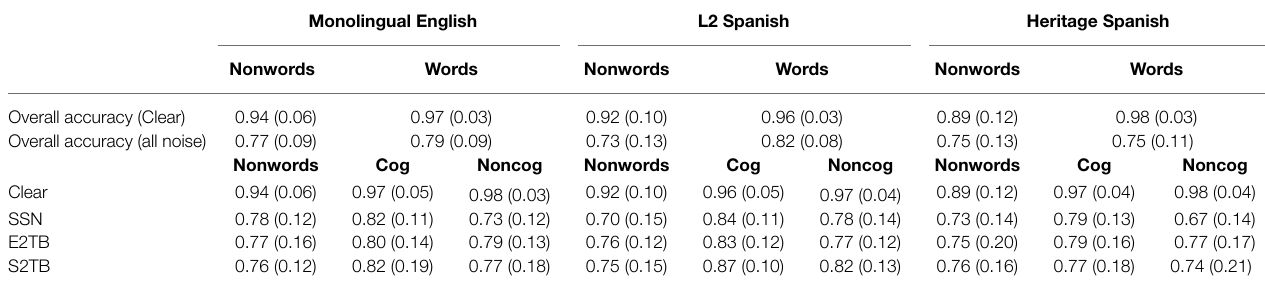
TABLE 3 | Descriptive statistics for accuracy (proportion correct trials and SD s) by condition and participant